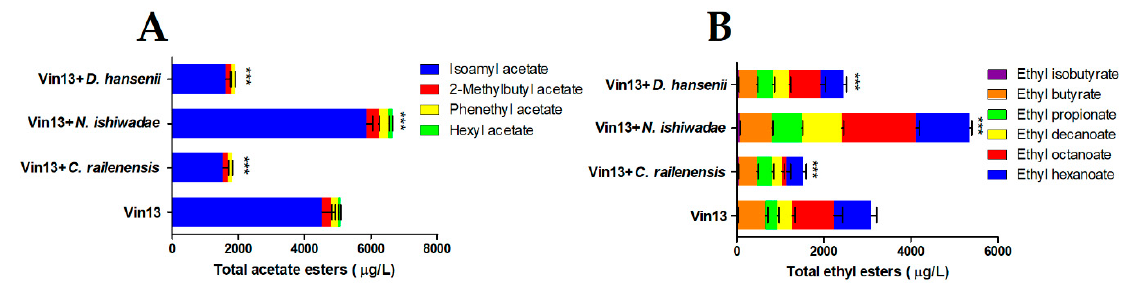
Figure 3. Sums of the ( A ) acetate esters (excluding ethyl acetate) and ( B ) ethyl esters in the final wines derived from the mixed-culture fermentations. Fermentations were done in triplicate. Error bar represents the standard deviation for each ester; *** p < 0.001. Table 3. Terpene and norisoprenoid composition of the Muscaris wines derived from the mixed-culture fermentations as determined with GC-MS.